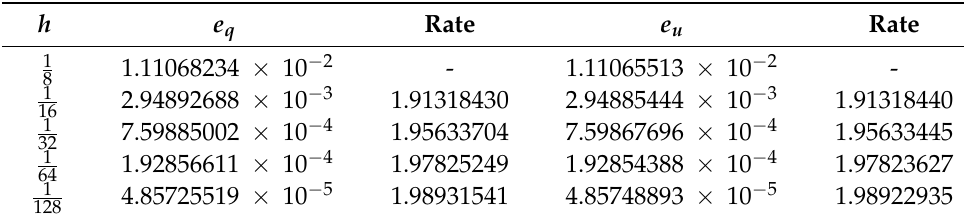
Table 8. Error e q and e u for the spatial convergence rates with α = 0.5.